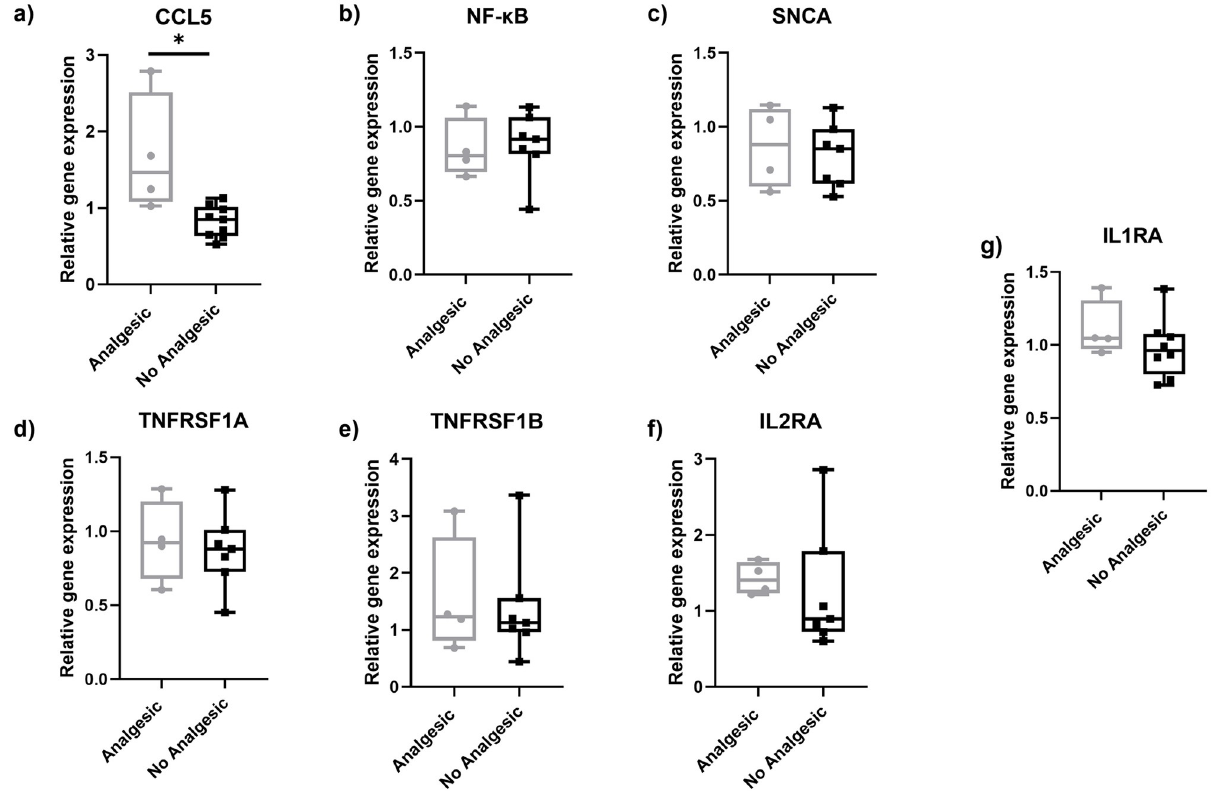
Fig 7. Effect of analgesic treatment in gene expression of inflammatory markers in PD Pain skin punch biopsies obtained from the lateral lower leg. Higher gene expression of CCL5 in PD with pain treated with analgesics compare to those not treated. No intergroup differences were found for the NF κ B (b), SNCA (c), TNFRSF1A (d), TNFRSF1B (e), IL2RA (f), and IL1RA (g). Data are expressed as median ± range. Abbreviations: CCL5 = C-C chemokine ligand 5, IL2RA = interleukin 2 receptor A, NF κ B = nuclear factor kappa B, PD = Parkinson’s disease, SNCA = synuclein alpha, TNFRSF1A = TNF receptor superfamily member 1A, TNFRSF1B = TNF receptor superfamily member 1B. � P < 0.05. Mann-Whitney-U